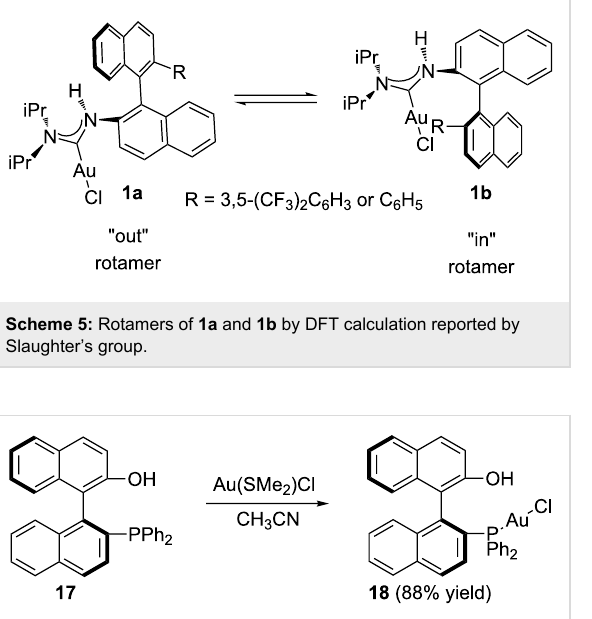
Figure 4: The crystal data of gold complex ( S )- 18 was deposited in the CCDC with the number 920617. Empirical formula: C 32 H 23 AuClOP; formula weight: 686.89; crystal color, colorless; crystal dimensions: 0.212 × 0.139 × 0.101 mm; crystal system: orthorhombic; lattice para- meters: a = 9.0411(7) Å, b = 13.4833(10) Å, c = 21.9878(16) Å, α = 90 o , β = 90 o , γ = 90 o , V = 2680.4(3) Å 3 ; space group: P 2(1)2(1)2(1); Z = 4; D calc = 1.702 g/cm 3 ; F 000 = 1336; final R indices [I > 2sigma(I)]: R1 = 0.0378; wR2 =